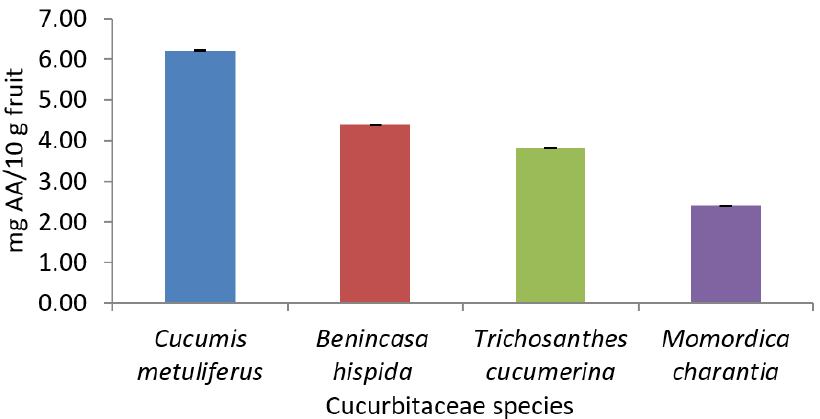
Figure 4. Ascorbic acid (AA) content of samples. The error bars represent ± standard deviation of three replicates.